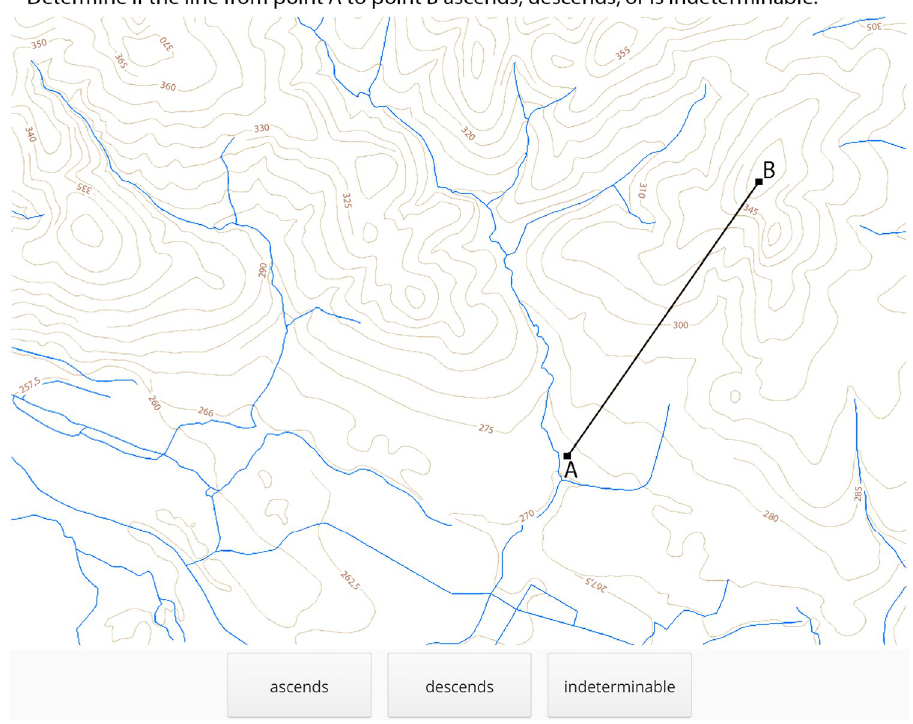
Fig 2. Test item created in the hypothesis platform for the pretest and